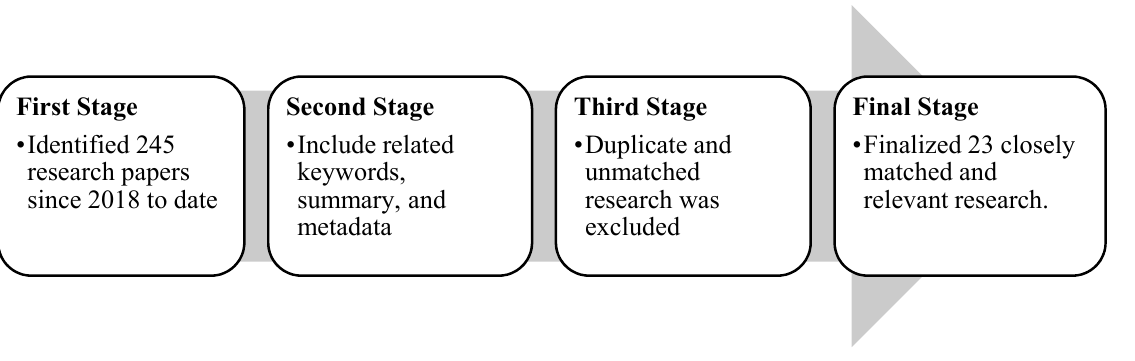
Figure 2. Research-selection methodology.